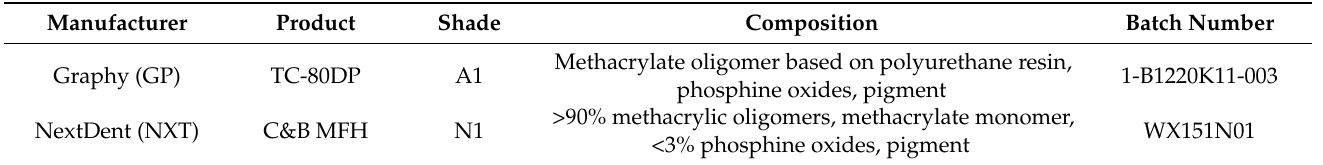
Table 1. Material composition of 3D printing materials used in this study provided by the